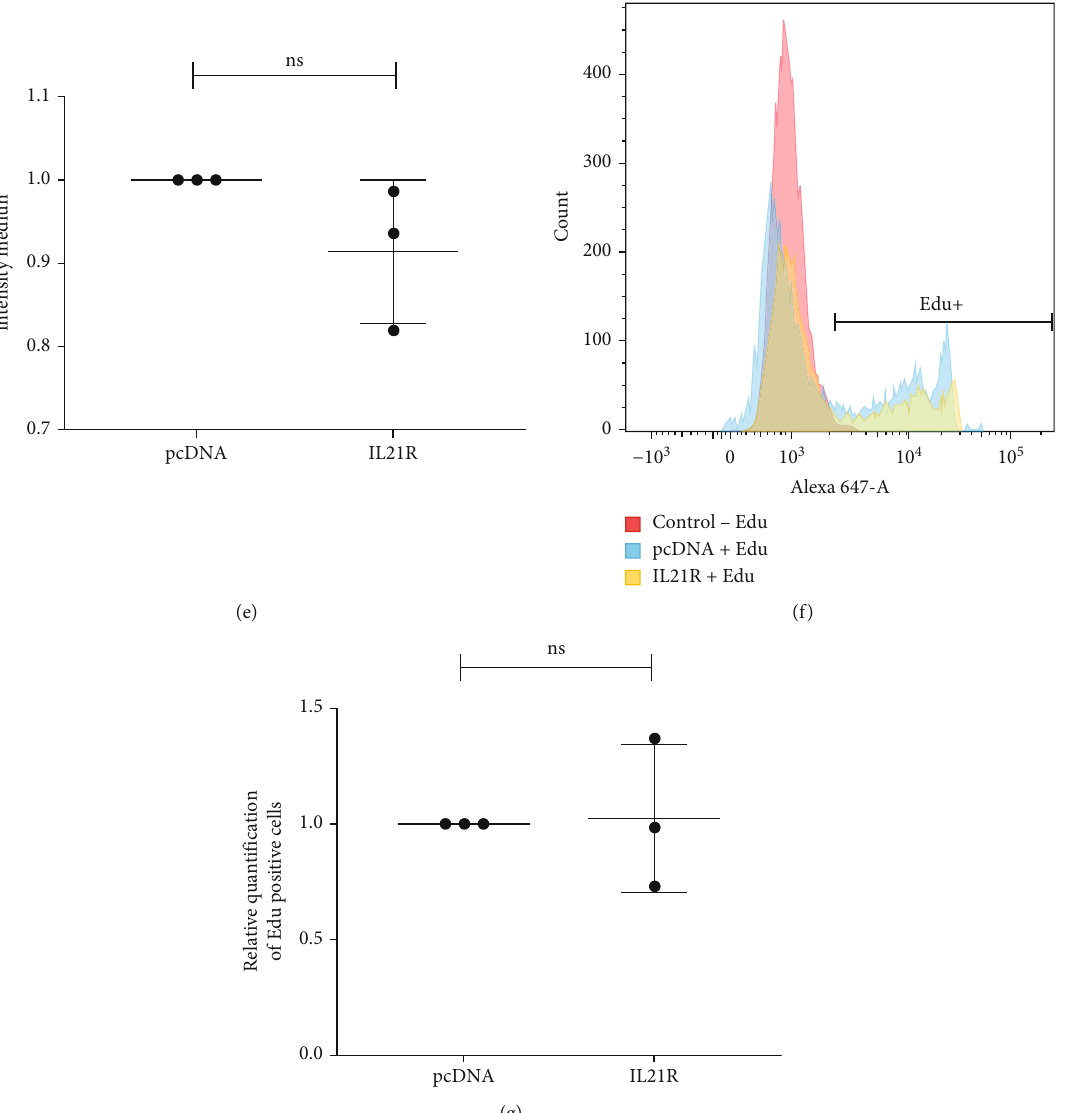
Figure 2: Overexpression of the IL21R gene in ADSCs. Cells were transfected with plasmid to overexpression of IL21R (IL21R), with a truncated plasmid (pcDNA) as a control. (a) Relative quanti fi cation of IL21R RNA normalized by GAPDH using qRT-PCR ( n = 3 ) (TAL22, 27, and 32). (b) Western blot analysis to verify IL21R protein levels ( n = 4 ) (TAL22, 27, 32, and 36). Protein levels of GAPDH were used as a control in the load, representative images of the donor TAL22. (c) Mitochondrial probe JC-10 measuring mitochondrial membrane potential ( ΔΨ ) in ADSCs with overexpressed IL21R ( n = 3 ) (TAL23, 27, and 32). JC-10 fl uorescence ratio at basal ( Δ F ) and uncoupling states ( Δ Fcccp ) was used to measure ΔΨ . DMSO was used as a control. (d, e) Rhodamine 123 assay to measure ΔΨ after overexpression of IL21R ( n = 3 ) (TAL23, 27, and 32). (d) Representative histogram with mitochondrial activity analysis. Cells without rhodamine (red curve) were used as a negative control. (e) Quanti fi cation of the relative fl uorescence intensity means of rhodamine- stained cells. (f, g) Proliferation analysis using EdU incorporation in ADSCs with overexpressed IL21R ( n = 3 ) (TAL22, 28, and 32). (f) Representative histogram with proliferation analysis by EdU incorporation. Cells without EdU (red curve) were used as a negative control. (g) Percentage of EdU-positive cells. Mean with SEM; Student ’ s unpaired t -test analysis: ∗ p < 0 : 05 , ns: not signi fi